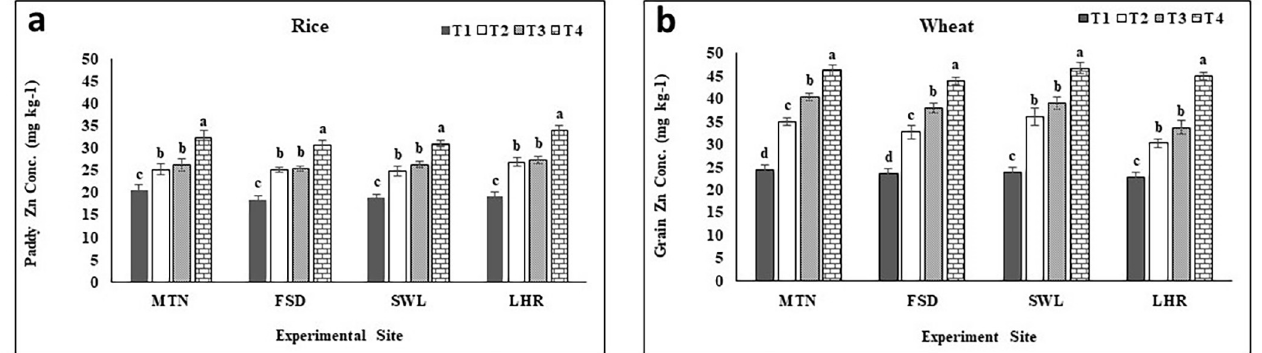
Fig 2. Effect of zinc sulfate and bioactive zinc coated urea on Zn concentration in paddy of rice and grains of wheat. MTN = Multan; FSD = Faisalabad; SWL = Sahiwal; LHR = Lahore; BAZU = Bioactive Zn coated urea (42% N; 1% Zn); T 1 (Urea 46% N @ 185 kg ha -1 + zero Zn), T 2 (Urea 46% N @ 185 kg ha -1 + ZnSO 4 33% Zn @ 15 kg ha -1 ), T 3 (BAZU 42% N @ 100 kg ha -1 + Urea 46% N @ 62 kg ha -1 + 1% bioactive Zn @ 1.00 kg ha -1 ), T 4 (BAZU 42% N @ 125 kg ha -1 + Urea 46% N @ 62 kg ha -1 + 1% bioactive Zn @ 1.25 kg ha -1 ). https://doi.org/10.1371/journal.pone.0282615.g002 recovered by plants grown in BAZU (T ) applied plots (9.4, 6.6, 7.4, and 7.1-folds higher) over 4 T (0.51, 0.83, 0.79, and 0.89%) at MTN, FSD, SWL, and LHR respectively. A similar trend was 2 observed in the case of agronomic efficiency i.e. relative to T (48, 56, 66, and 52 kg kg -1 ), 130, 2 98, 84, and 113% increment was noted under T at MTN, FSD, SWL and LHR respectively 4 (Fig 4C). Wheat Growth and yield attributes. Table 3 represents the results of spike length (SL), number of grains per spike (GS), number of tillers, 1000 grain weight, biomass yield, and harvest index (HI). As compared to T of the respective locations, SL was recorded higher at MTN (16%) 1 and SWL (13%) under T while at FSD and LHR, SL remained statistically unchanged among 4 ), GS were significantly higher in T plants while unchanged treatments. Relative to control (T 1 4 under T and T compared to T of the respective location. Relative to T of each location, GS 2 3 1 1 were enhanced by 19, 10, 13, and 12% in presence of BAZU (T ) at MTN, FSD, SWL, and LHR 4